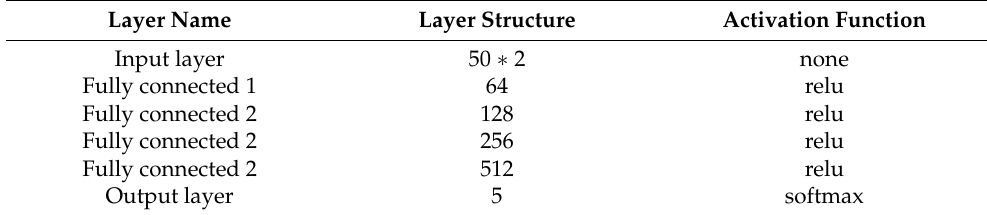
Table 7. Fully connected neural network model parameters.